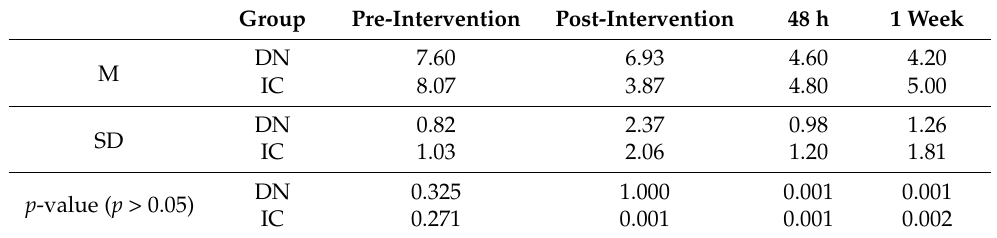
Table 4. Mean (M), standard deviation (SD) and p -value of VAS by group and time of acquisition. Group Pre-Intervention Post-Intervention